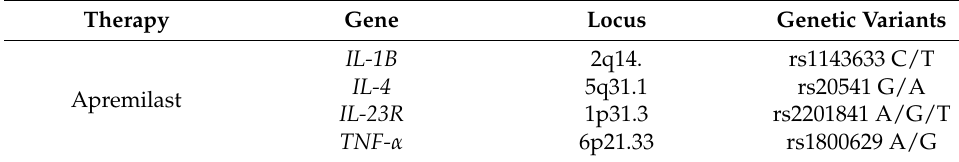
Table 3. Genes and genetic variants potentially involved in the response to